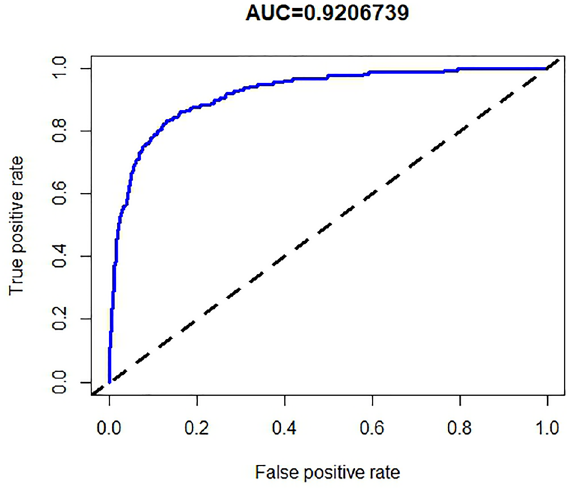
Figure 2. ROC curve plot corresponds to the nomogram.